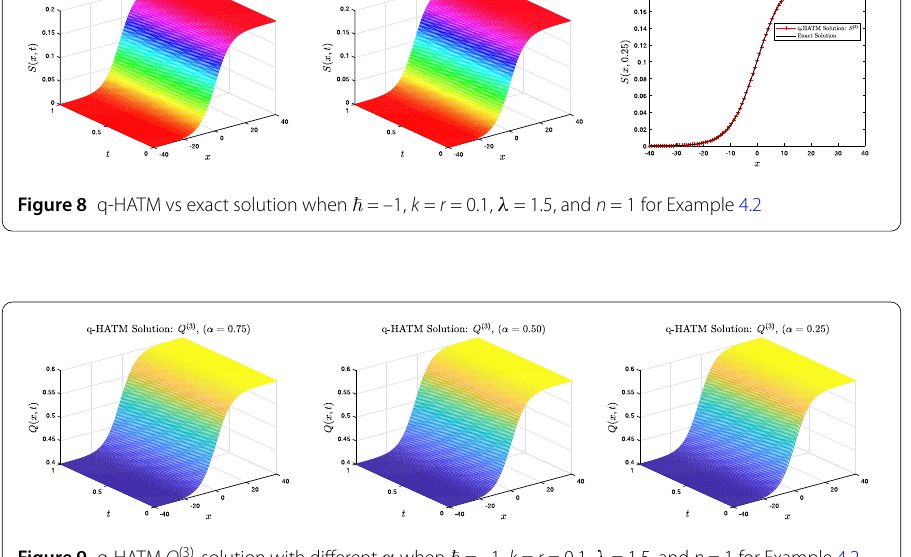
Figure 9 q-HATM Q (3) -solution with different α when (cid:2) = –1, k = r = 0.1, λ = 1.5, and n = 1 for Example 4.2